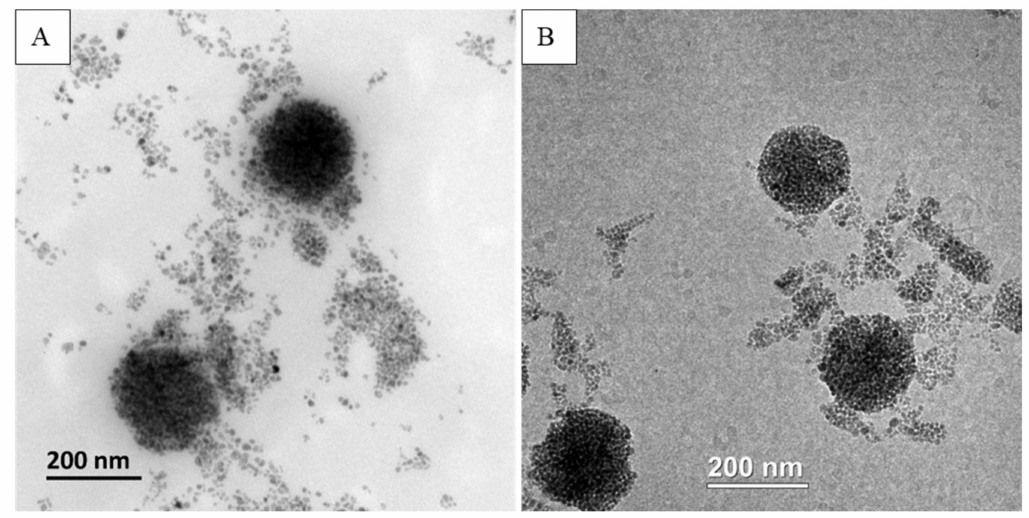
Figure 11. ( A ) TEM and ( B ) crytoTEM of REV_MCLs.